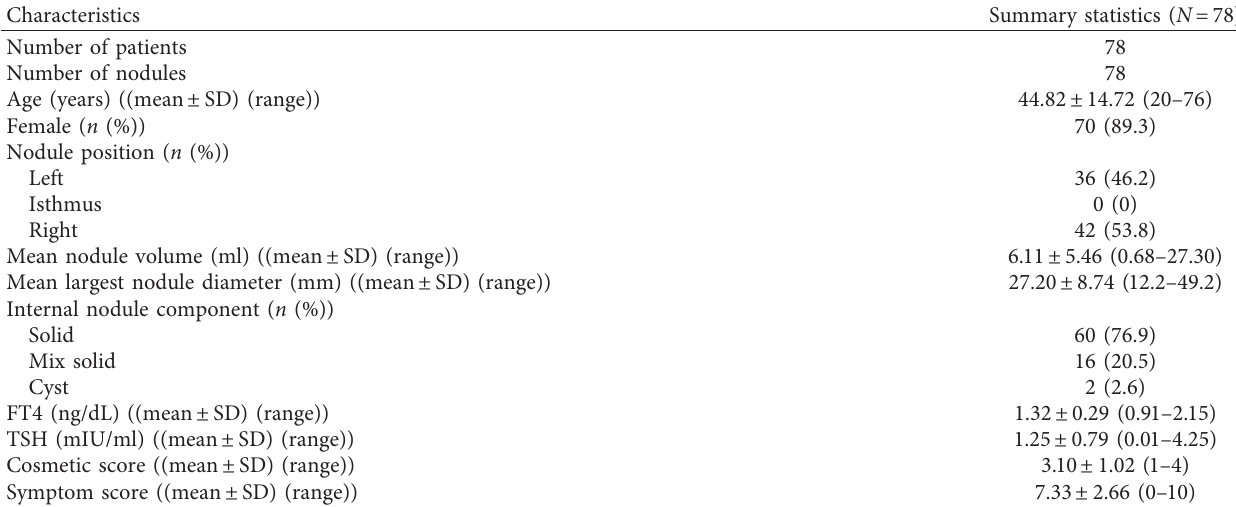
Table 1: Baseline characteristics of the patients and nodules.